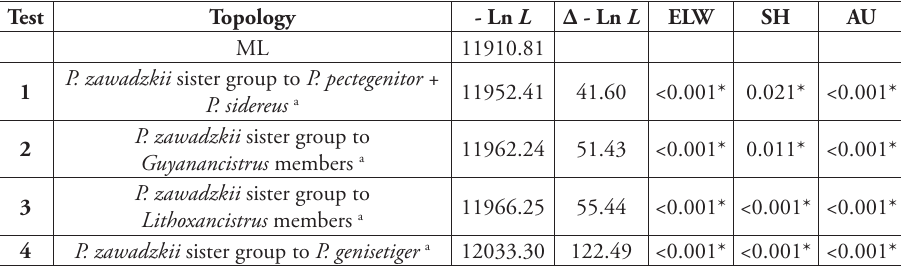
Table 2. Likelihood-based tests for alternative topologies. SH and AU are probability values obtained from the Shimodaira-Hasegawa and the Approximately Unbiased tests (Shimodaira 2002). Asterisks de- note significant values (P<0.05 for SH and P<0.01 for AU and ELW) that imply the topology is